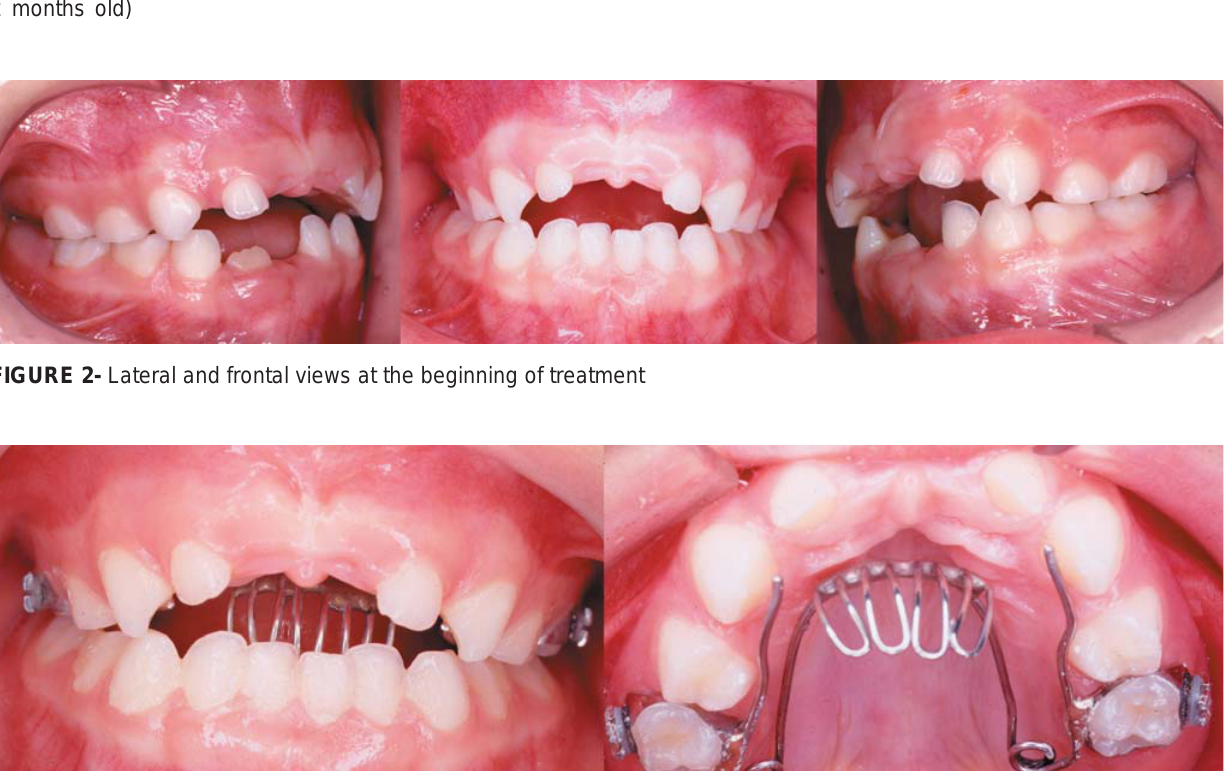
FIGURE 1- Frontal and lateral facial views and cephalometric lateral radiograph at the beginning of treatment (5 years and 2 months